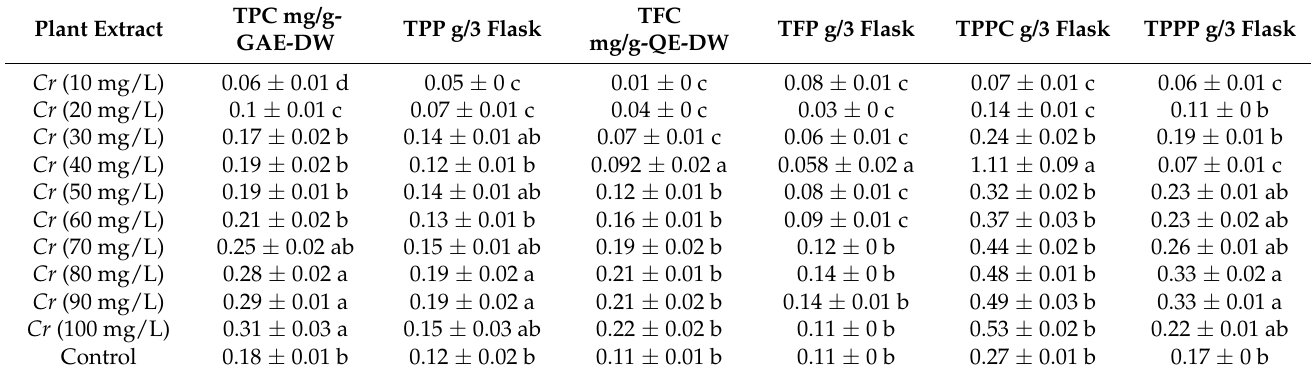
Table 3. The effect of different Cuscuta reflexa ( Cr ) extracts on total phenolics content (TPC), total phenolic production (TPP), total flavonoids content (TFC), total flavonoids production (TFP), total polyphenolics content (TPPC), and total polyphenolics production (TPPP) in Stevia rebaudiana . Mean data along with standard deviation ( ± SD) and least significant differences were determined using Statistix software (v. 8.2; USA). Mean values with common alphabets are significantly different at p <